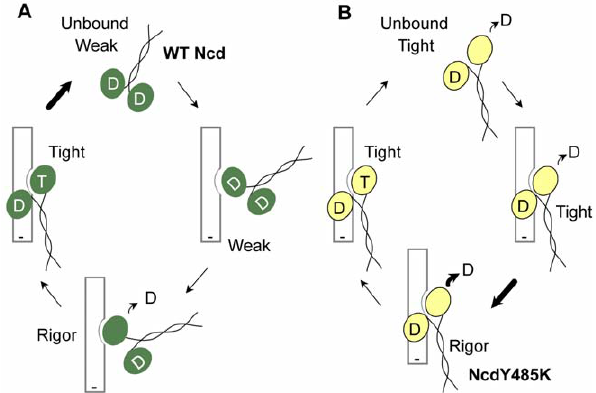
Figure 7. Model of Ncd hydrolysis cycle. (A) Wild-type Ncd exists in a tight-ADP/weak-microtubule binding state in solution (bold arrow) and undergoes cycles of weak-to-tight microtubule binding coupled to nucleotide changes in the head that interacts with the microtubule (D, ADP; T, ATP). (B) NcdY485K and the other two NcdY485 mutants bind tightly to microtubules and may release ADP even when not bound to microtubules; the stable state is the weak-ADP/tight-microtubule binding state (bold arrow), in contrast to wild type. NcdY485K is depicted in a tight microtubule-binding, stalk-rotated conformation like NcdN600K (PDB 1N6M) throughout the cycle [40]; however, the stalk must rotate back to a pre-stroke conformation at least transiently during the cycle for the motor to produce force and support microtubule gliding in motility assays.